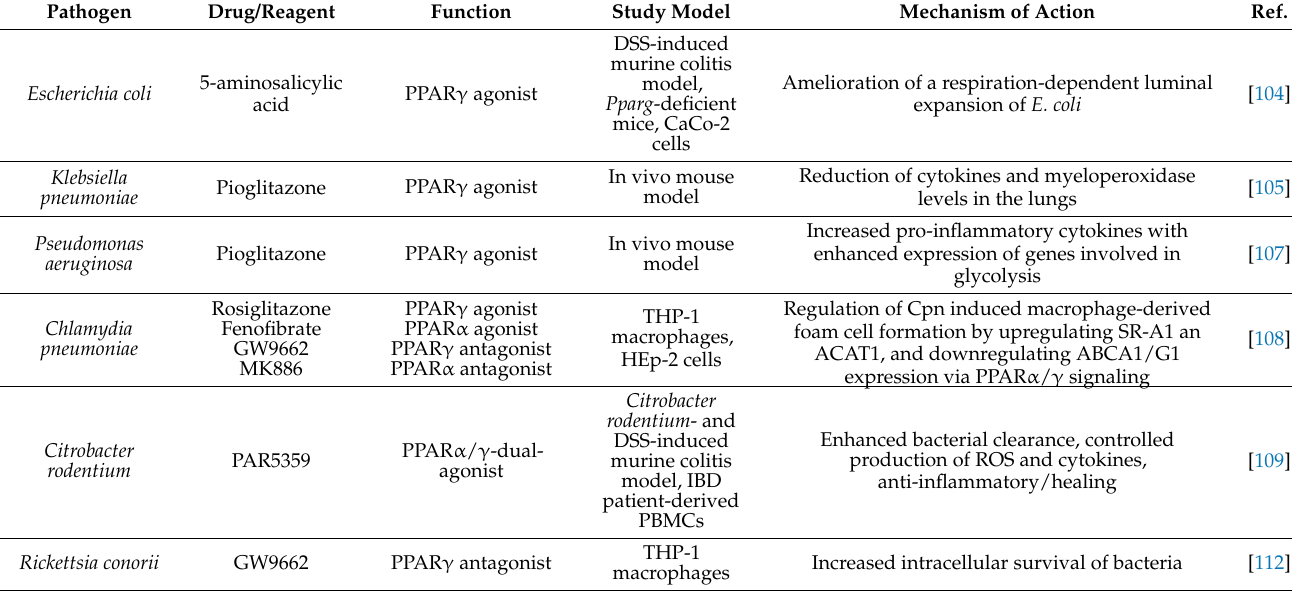
Table 2. Roles of PPAR agonists/antagonists in bacterial